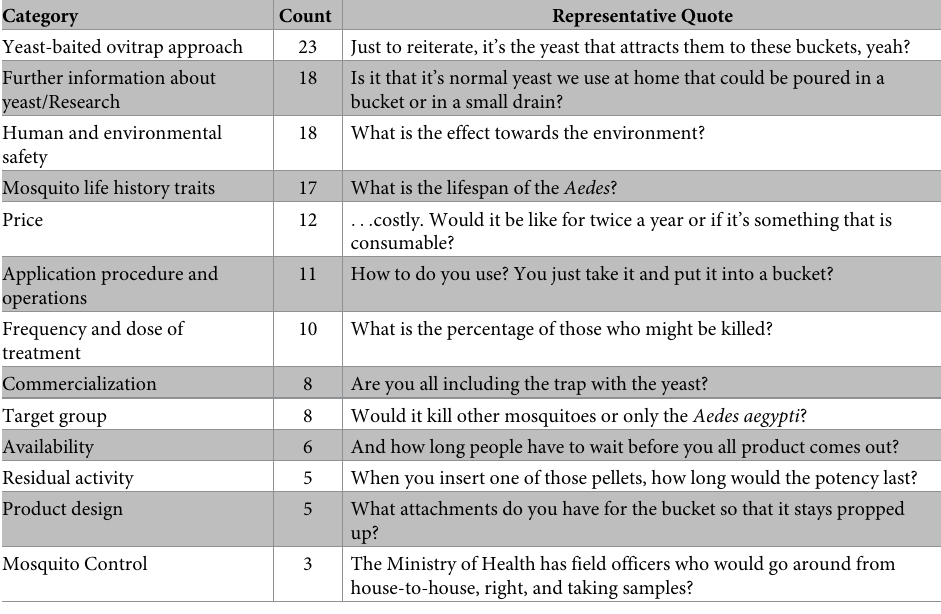
Table 3. Common categories of information gathering questions at the community engagement forums.